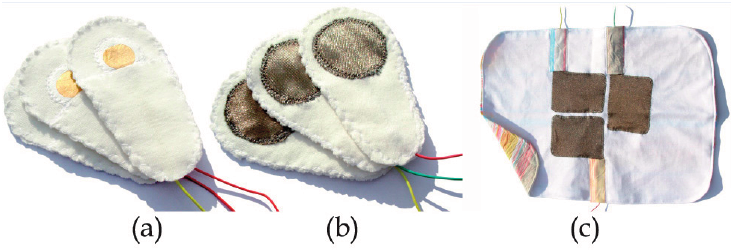
Figure 2. Textile electrodes for ECG measurement [30]. Copyright © 2010 Multi Science